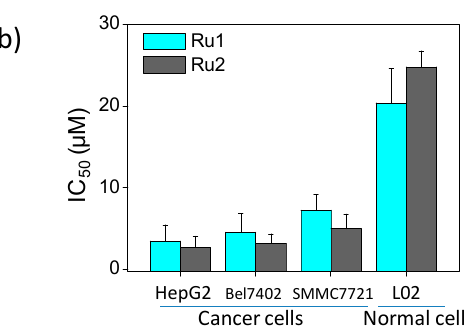
Figure 1. Ru complexes exert in vitro anticancer activities. ( a ) Chemical structure of Ru complexes; ( b ) Cytotoxicity of Ru complexes towards human cancer and normal cells. Human hepatocellular carcinoma (HCC) and L02 cells were treated with Ru complexes for 72 h. The cell viability was subsequently investigated via an MTT assay.